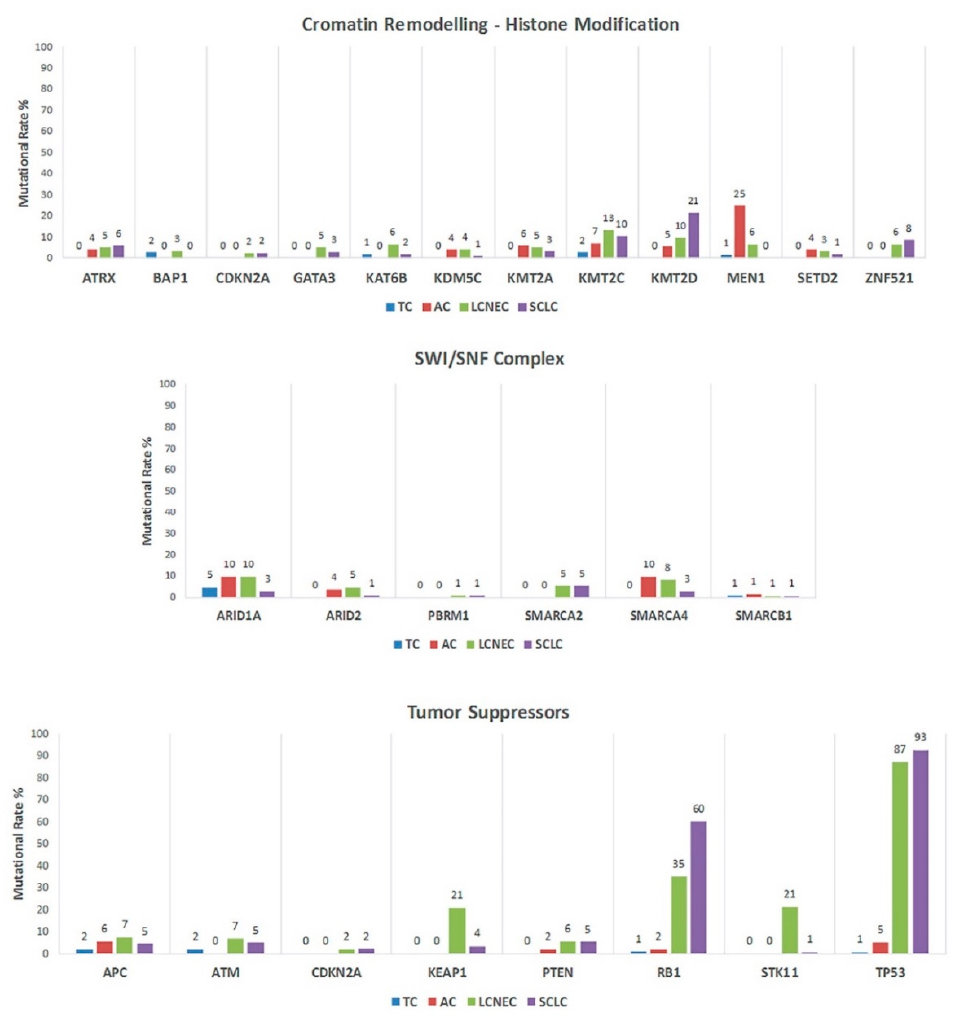
Figure 3. Mutation rate of tumor suppressors and chromatin modifiers genes in all four histological variants. Abbreviations: TC, typical carcinoid; AC, atypical carcinoid; LCNEC, large cell neuroendocrine carcinoma; SCLC, small cell lung carcinoma.